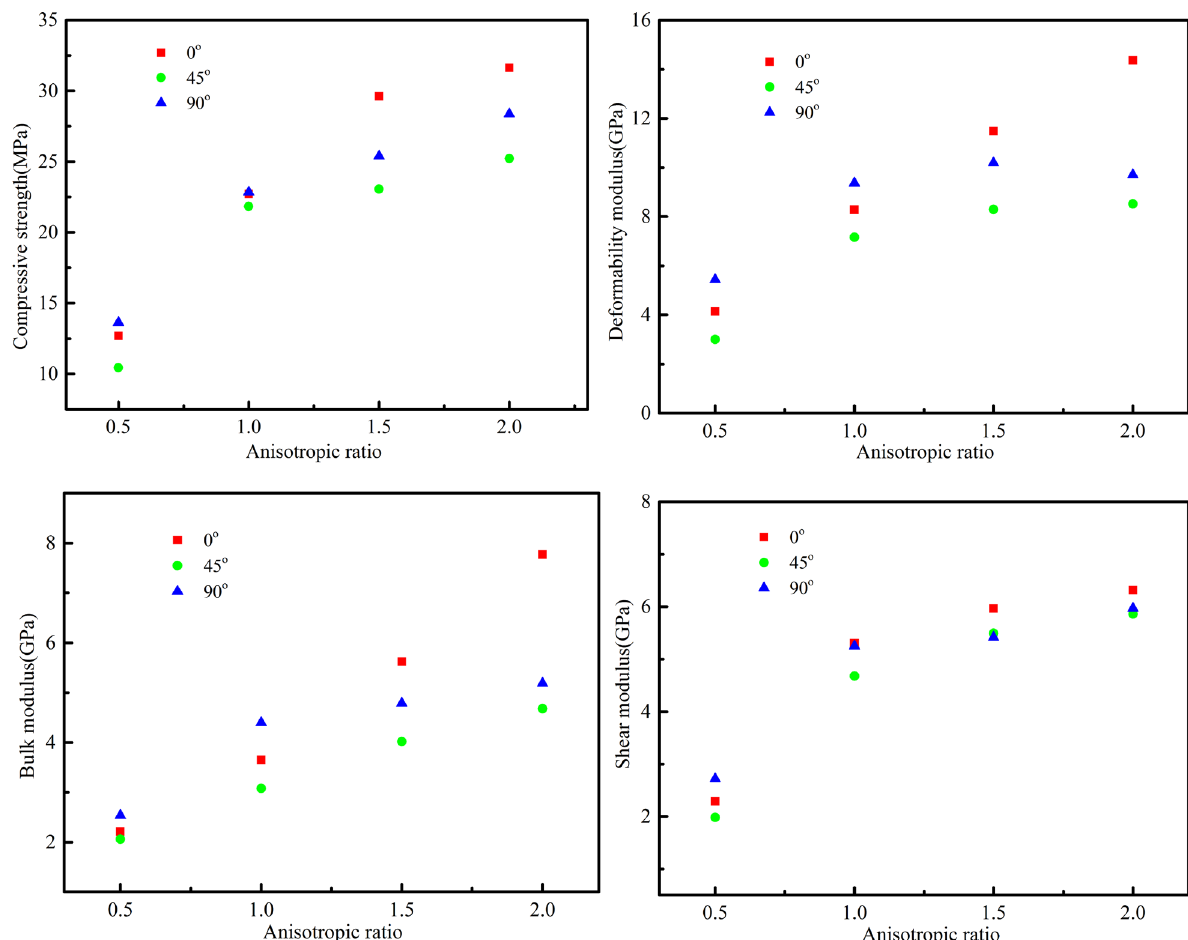
Fig. 12 Mechanical parameters under different anisotropy ratios and bedding